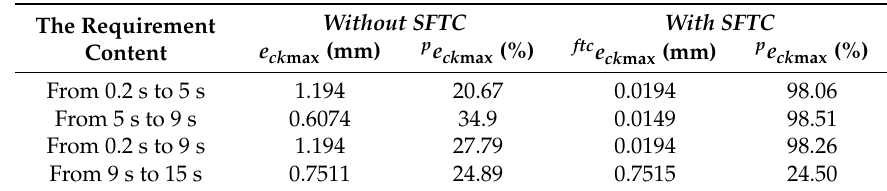
Table 2. The error assessment e ck max with disturbance d k = 0.